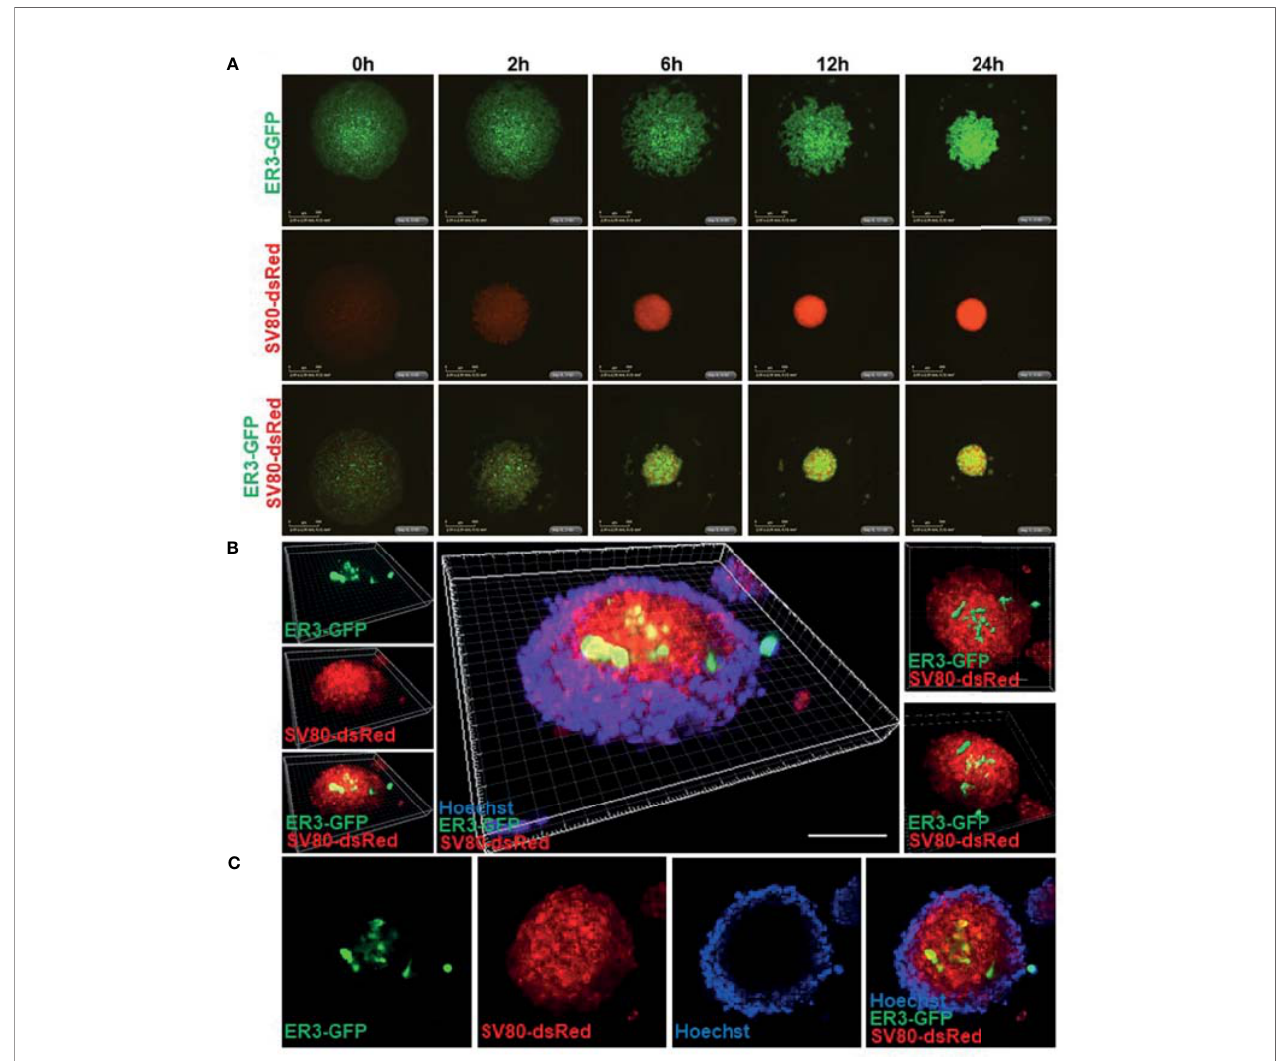
FIGURE 5 | Real-time spheroid formation and compound penetration in the 3D heterotypic co-culture spheroids made of fl uorescent transgene expressing cells. (A) HCC827 ER3 cells and SV80 fi broblast cells were stably transduced by lentiviral particles harboring the GFP and dsRed transgene, respectively. Transduced cells were subsequently sorted by FACS to obtain a population of cells with a uniform transgene expression. 3D spheroid formation was studied by time-lapse imaging using the IncuCyte system. Images were obtained every 2 h using 4x objective. Representative images from the 0-24 h time interval are shown for homotypic ER3 and SV80 cells, as well as the ER3 and SV80 heterotypic spheroids. Scalebar = 500 m m. (B) The illustration shows a 3D heterotypic co-culture spheroid of HCC827ER3 (GFP) and SV80 (dsRed) counterstained by Hoechst (blue). Images obtained by Zeiss confocal microscope. Z-stack depth = 71.77 µm. Reconstruction by IMARIS software. Scale bar: 100 µm. (C) ER3 and SV80 heterotypic spheroids were stained for 7 days with Hoechst to visualize the penetration of drugs of comparable